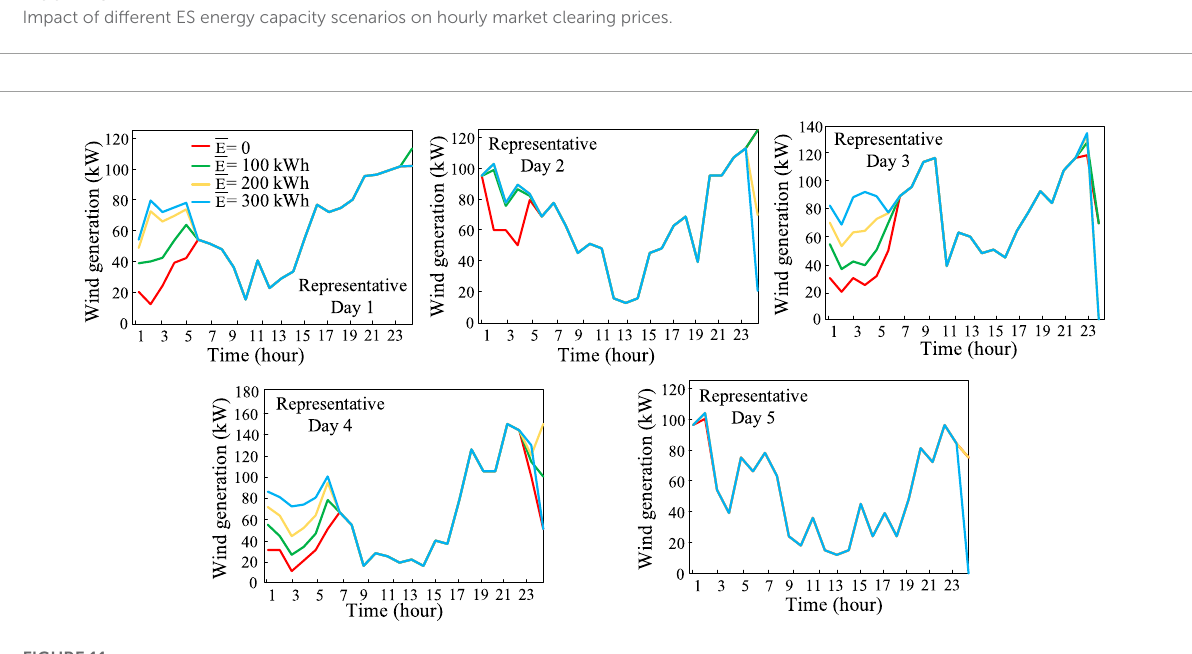
FIGURE 11 Impact of different ES energy capacity scenarios on hourly wind generation